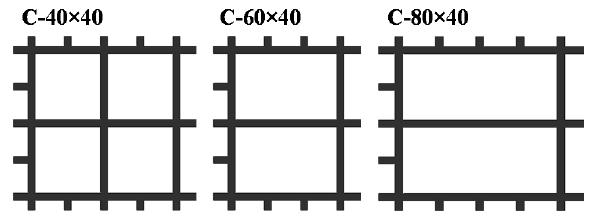
Figure 5. Schematic diagram of carbon fiber grid density.